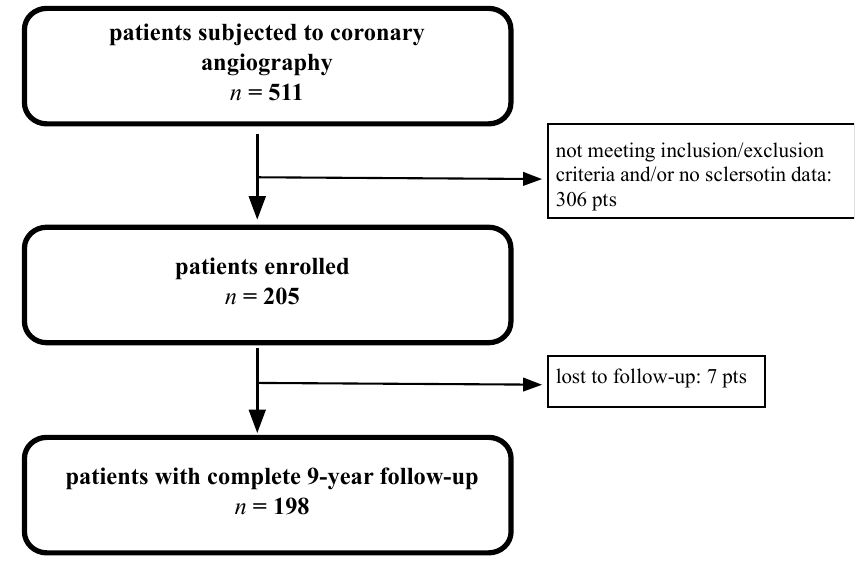
Figure 1. Study flow chart . Table 1. Baseline characteristics and laboratory findings.